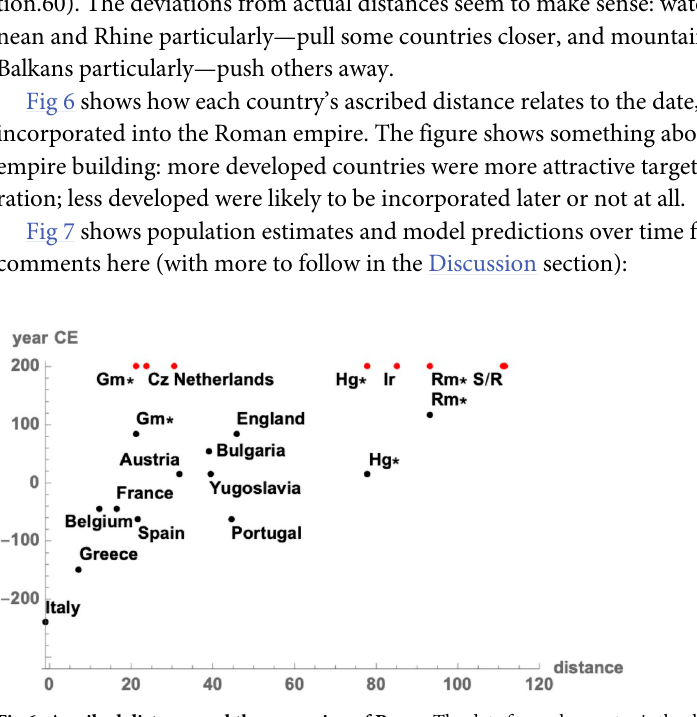
Fig 6. Ascribed distance and the expansion of Rome. The date for each country is the date at which most of the modern country was incorporated into the Roman empire. Countries never incorporated are assigned a nominal date of 200 CE. Countries incorporated at most partially appear twice, with � . Gm = Germany, Cz = Czechoslovakia, Hg = Hungary, Ir = Ireland, Rm = Romania, S/R = Scandinavia / Russia.